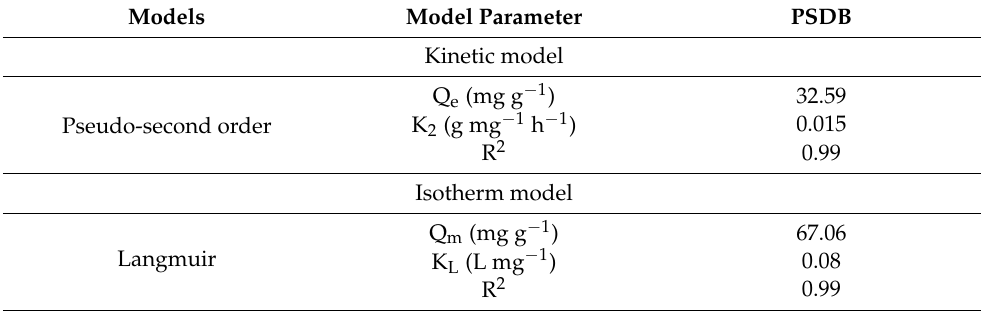
Table 3. Adsorption kinetics and isotherm parameter values for adsorption of Ni 2+ by